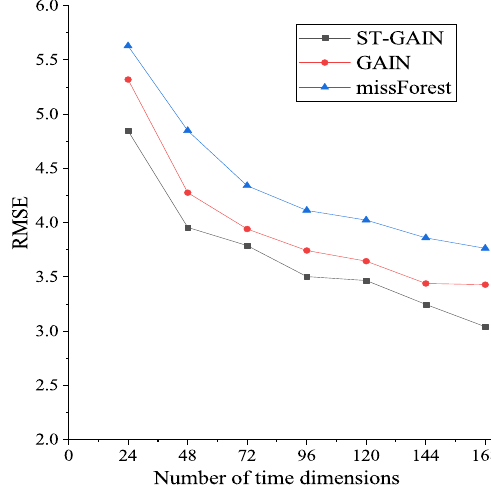
Figure 12. RMSE for different time dimensions.